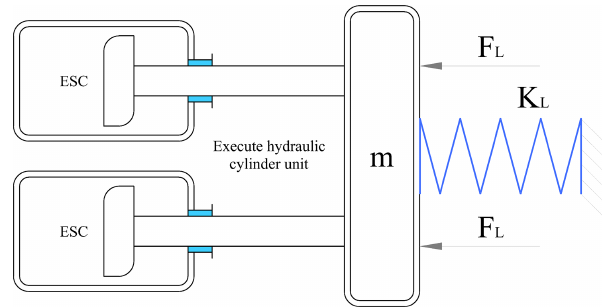
Figure 5. System diagram of parallel form of electrohydraulic servo